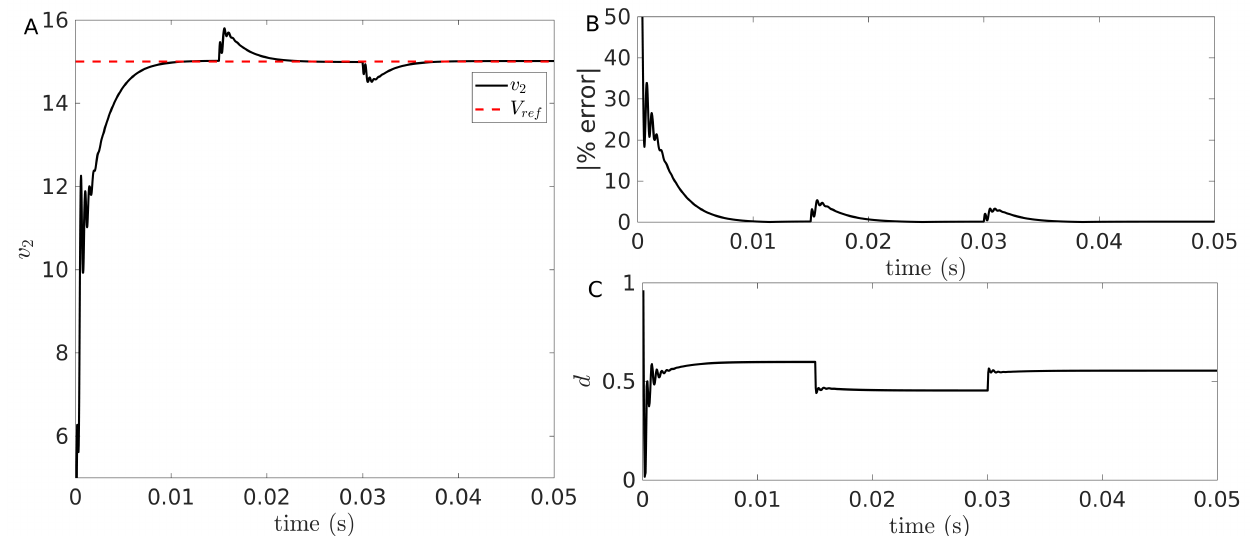
Figure 9. Time trace of the ramp controlled sZETA converter under perturbations of the input: ( A ) voltage trace; ( B ) error percentage; ( C ) duty cycle. In all panels, V in = 10 V for t < 15 ms, V in = 18 V for 15 ms ≤ t < 30 ms, and V in = 12 V for t ≥ 30